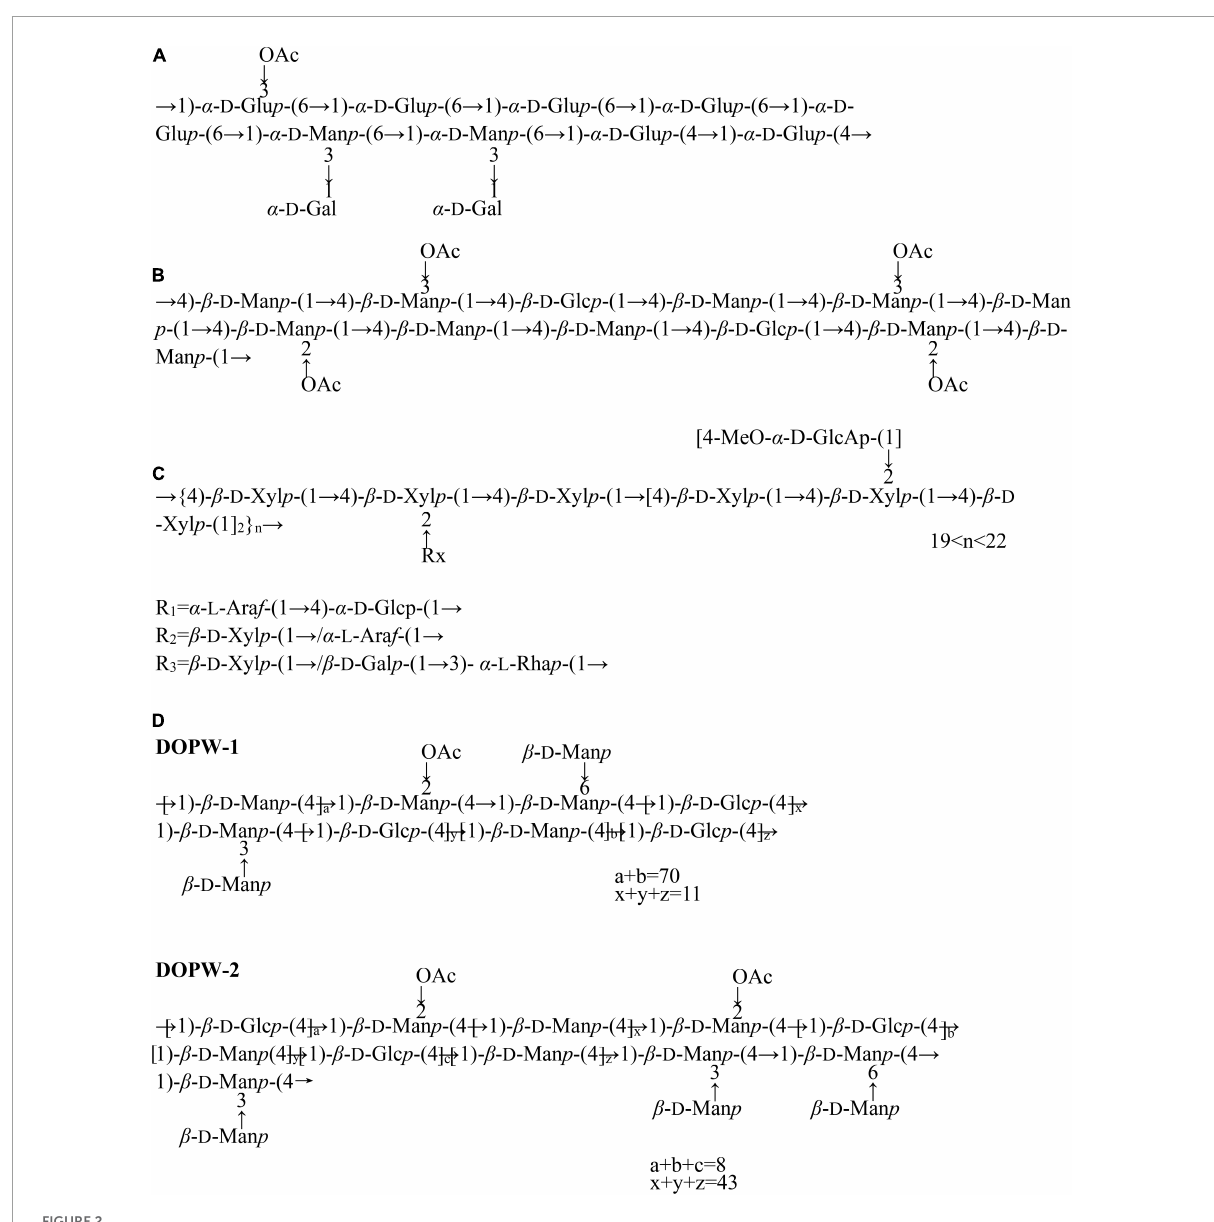
FIGURE2 The chemical structure of D. officinale polysaccharides. (A) The D. huoshanense polysaccharide (HPS-1B23), (B) two component polysaccharides (DOP-1, DOP-2), (C) a novel polysaccharide (S32), (D) two novel polysaccharide fractions (DOW-1,